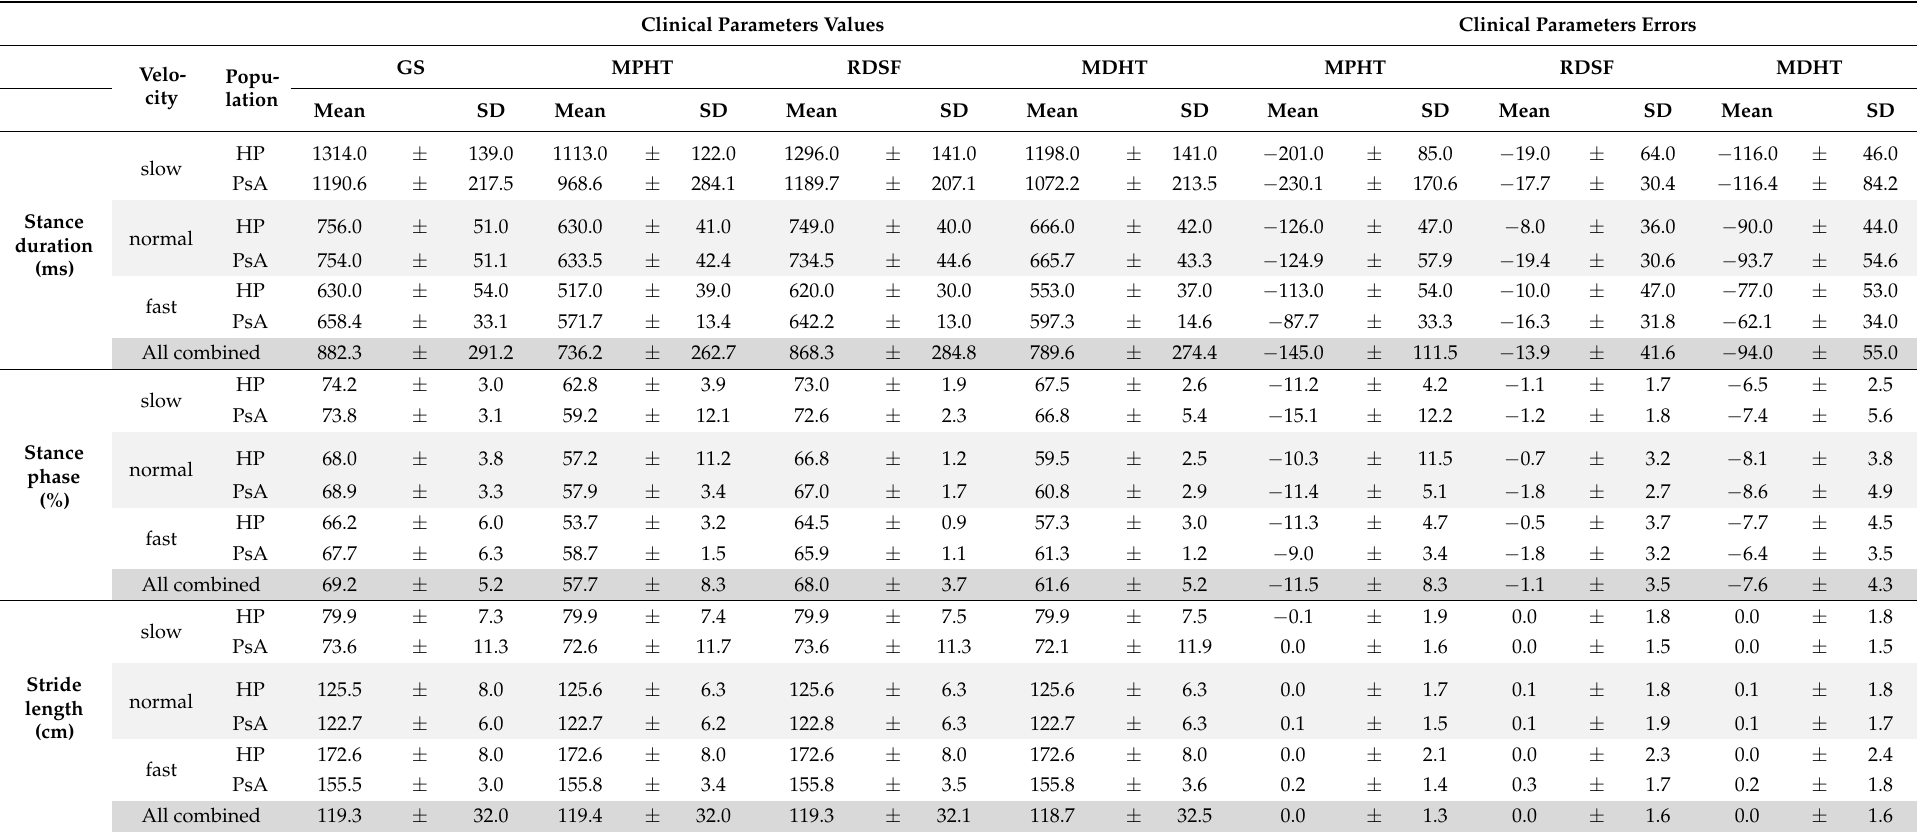
Table 2. Clinical gait assessment parameters values and accuracy compared to force plates for slow, normal, and fast walking